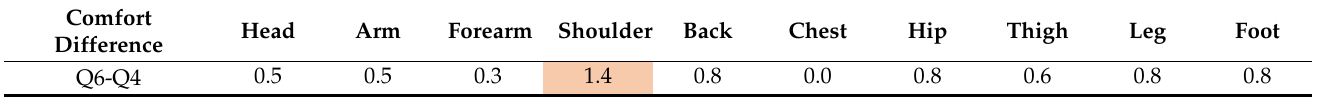
Table 11. Difference between thermal comfort levels at Q4 and Q6 for the hot-sensitive